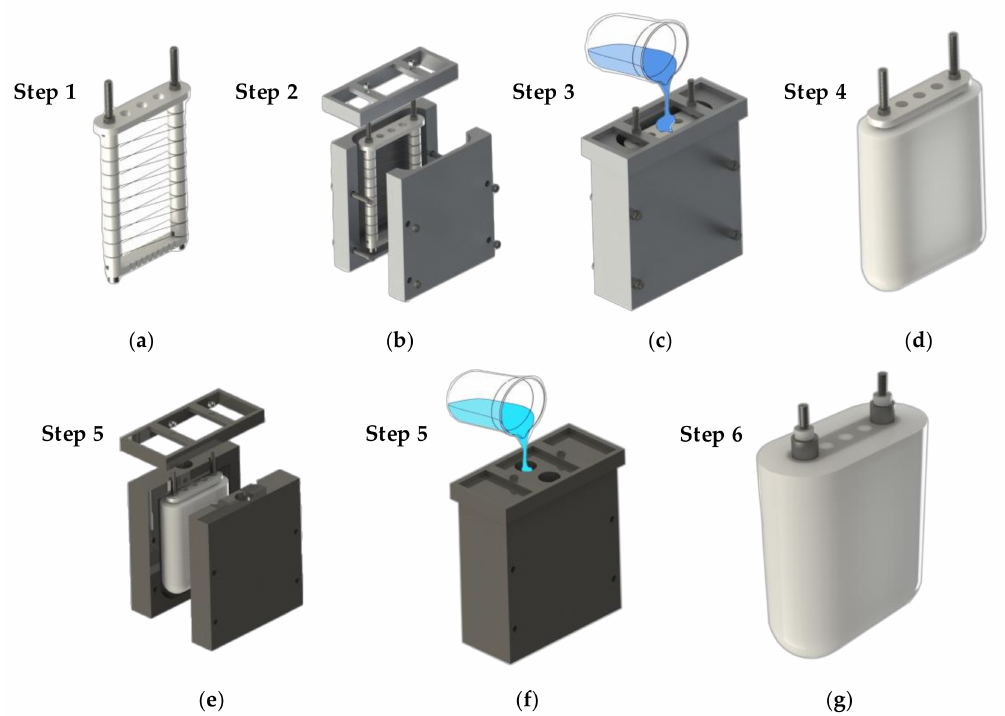
Figure 5. Fabrication process of para ffi n phase-change BCM: ( a ) assembly of heating unit; ( b ) assembly of para ffi n mold; ( c ) para ffi n pouring; ( d ) para ffi n mold release; ( e ) assembly of shell mold; ( f ) the silica